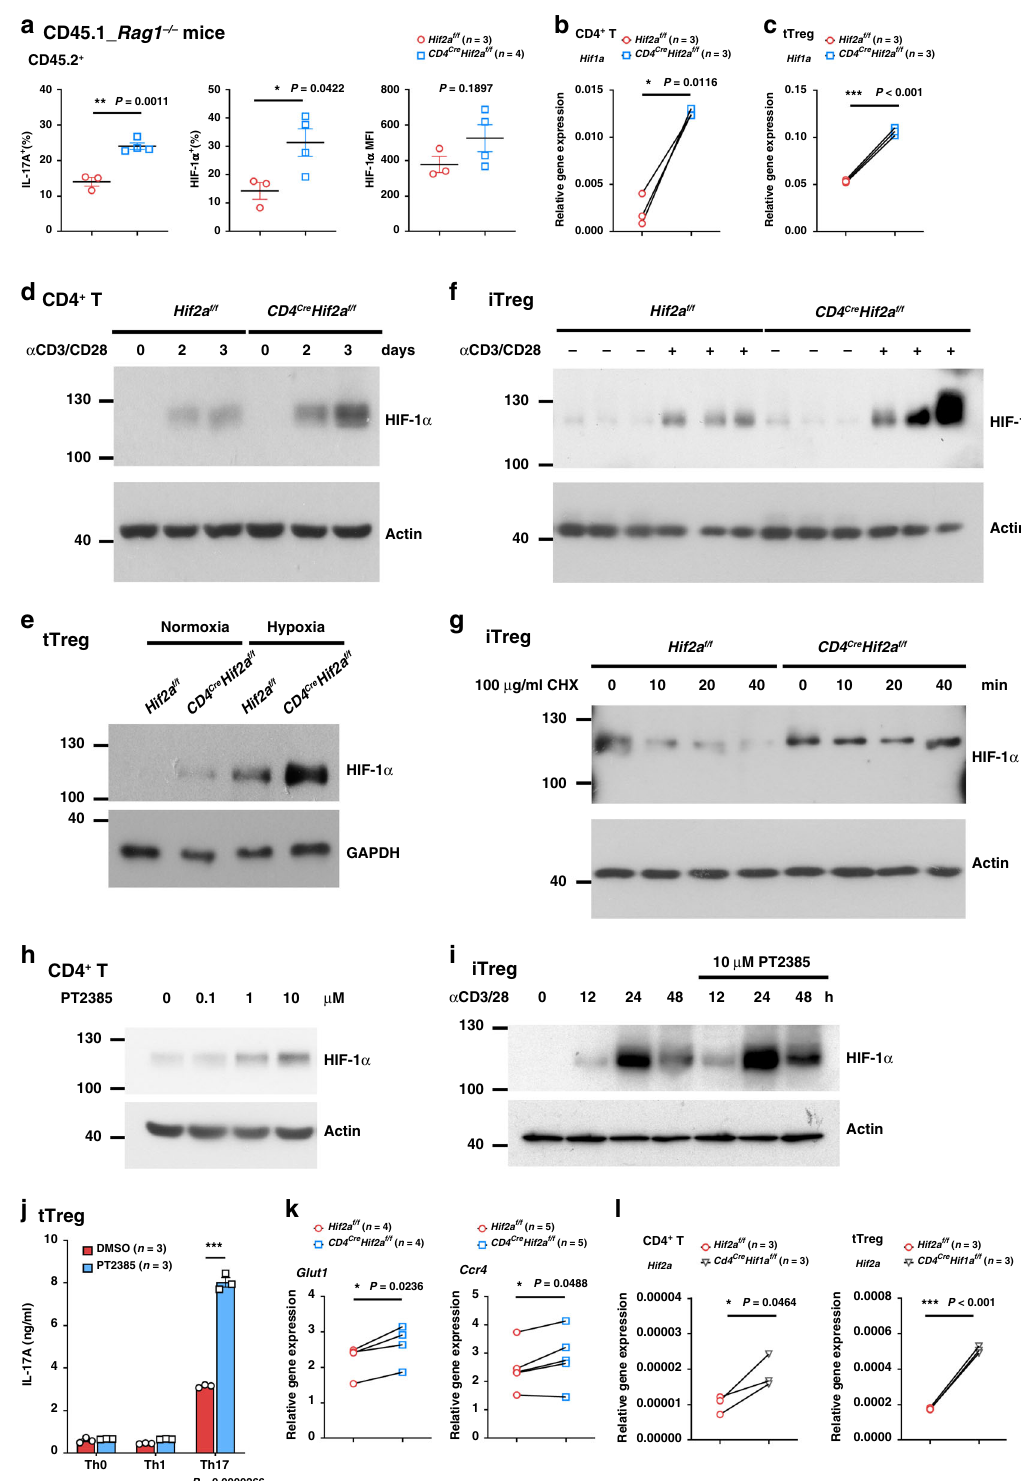
intensity, MFI) in iTreg cells are higher in HIF-1 α -KO iTreg cells relative to control when differentiated under normoxic conditions (Fig. 1c). For iTreg cells differentiated under hypoxic conditions, when HIF-1 α protein is induced, both the proportion of Foxp3 + cells and Foxp3 MFI are signi fi cantly elevated in Cd4 Cre Hif1a f/f iTreg cells at higher concentrations of TGF- β (Fig. 1d). Similarly, both those attributes are higher in Foxp3 Cre Hif1a f/f iTreg cells developed under hypoxia than for Foxp3 Cre and Foxp3 Cre Hif2a f/f